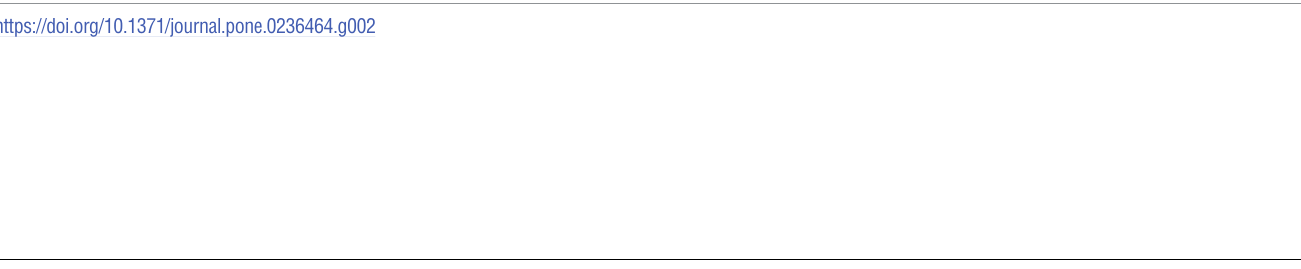
Fig 2. Estimated reproduction number R ð t Þ for selected countries based on the data up to June 30, 2020. The US (left) and China (right) are shown based on the 0 data up to June 30, 2020. The blue dots and the red dashed curves represent the observed data and the model-based predictions, respectively, with 95% confidence